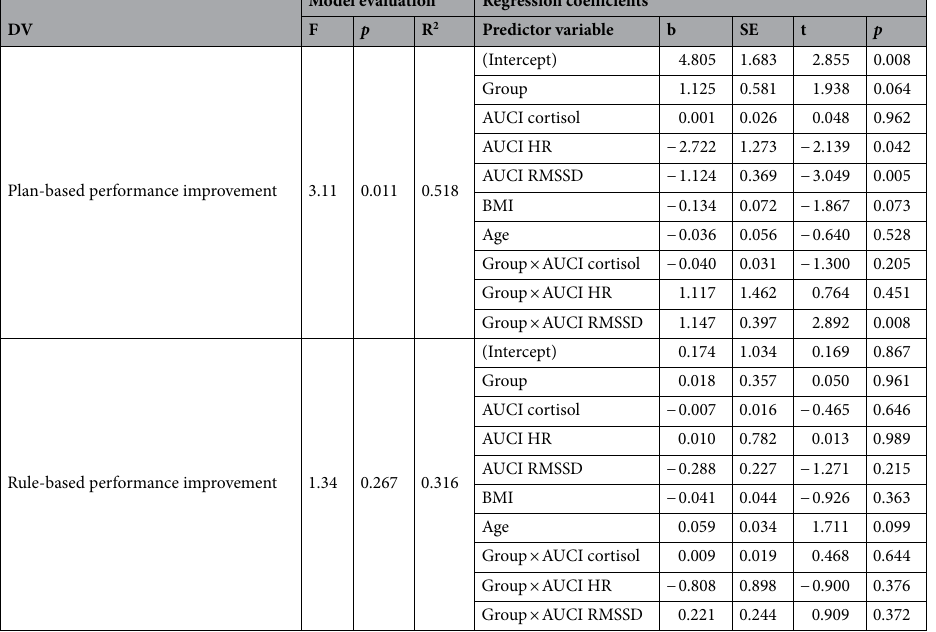
Table 2. Outcome from the regression analyses. Displayed is the outcome of the ANOVA that evaluates whether the current model predicts the dependent variable better than assuming the mean of the dependent variable. R 2 indicates the share of variance in the dependent variable explained by the model. Further, the regression coefficients with their corresponding t- and p -values are displayed for each predictor contributing to the current model.